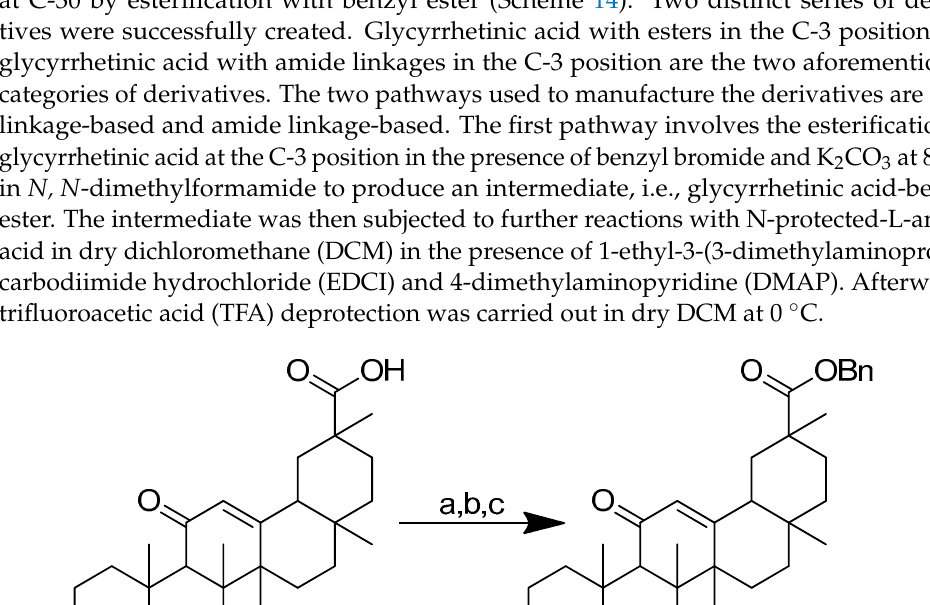
Figure 19. Glycyrrhetinic